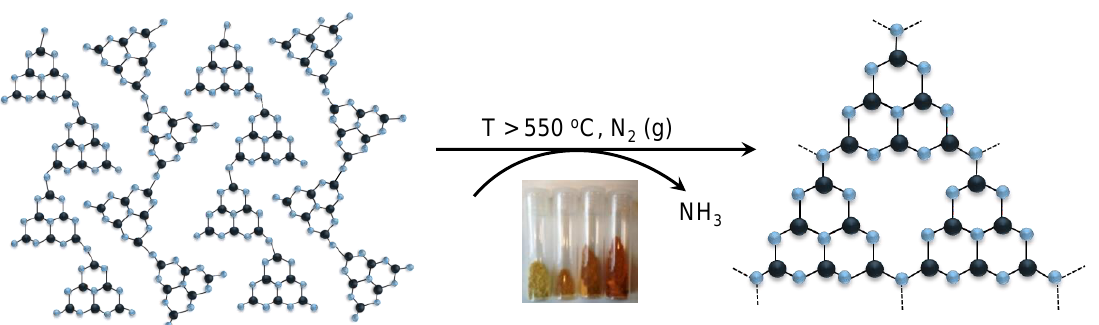
Figure 1. Left : The structure of Liebig’s melon that provides a crystalline model for polymeric gCNH structures. The structure contains chains of linked heptazine (tri- s -triazine) units; Right : When precursors such as melamine, dicyandiamide, or urea are treated above 550 °C in an inert (e.g., N 2 ) atmosphere, they undergo condensation reactions with the release of ammonia molecules to form series of amorphous or nanocrystalline polymeric C x N y H z structures known generally as the graphitic carbon nitride (gCNH) family of materials. A drawing of a laterally polymerized unit formed from “sideways” condensation of melon-like polyheptazine chains is shown. Blue balls represent N atoms; black balls represent C atoms; H atoms are not illustrated, for clarity. The picture under the arrows illustrates the deepening color of different gCNH materials formed as a function of increasing synthesis temperature, from left to right.